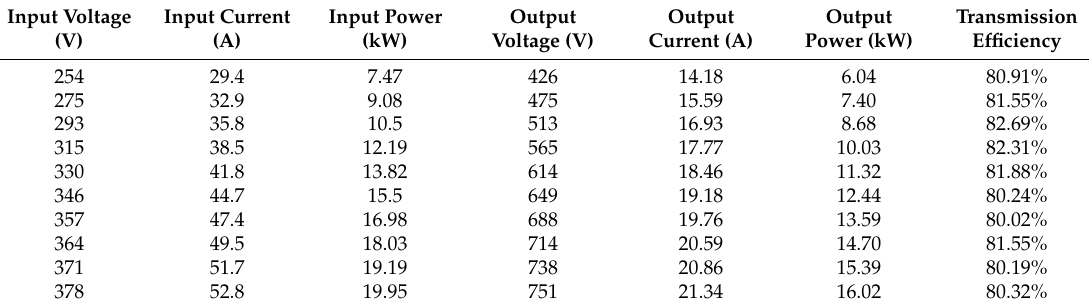
Figure 16. The input voltage, the output voltage, the input current, and the output current.